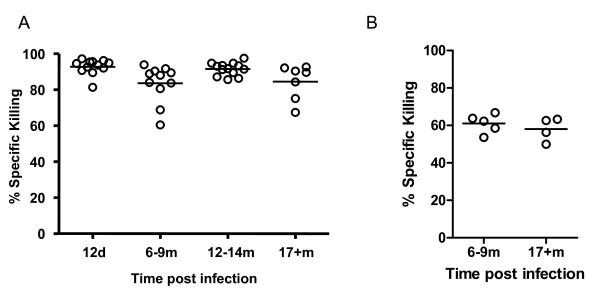
Virus-specific CD8 T cells present in latently-infected mice retain CTL function with age. Cytolytic activity of ORF61-specific CD8 T cells was measured at the indicated times post infection using a 16-17 h (Panel A) or a 4 h (Panel B) in vivo CTL assay as described in the Materials and Methods. Symbols represent specific killing calculated for individual mice. Bars indicate the medians calculated from data compiled from three independent experiments. Significance was assessed using the Mann-Whitney rank test (two-tailed, 95% confidence).